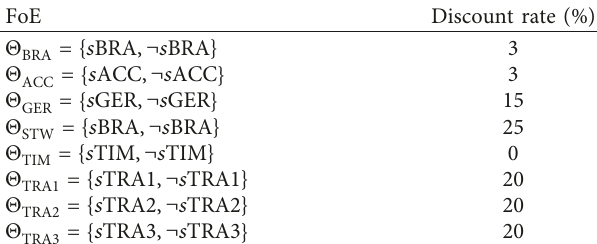
Table 8: FoE and their discount rate. Table 9: An example of compatibility